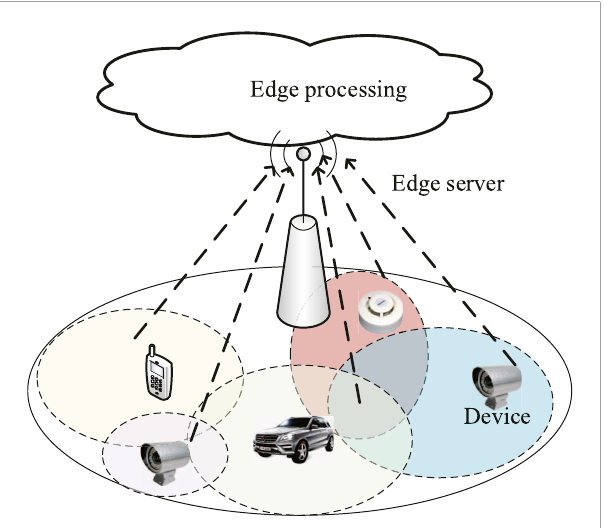
FIGURE 1 The considered system with an edge server and K devices. Different colored areas represent the perception areas of different devices.